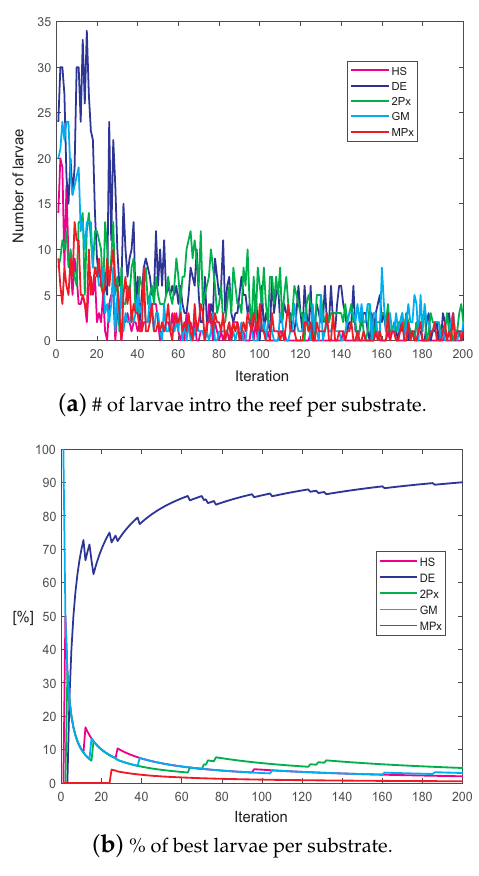
Figure 7. Number of larvae entering to the reef and percentage of best larva generated per substrate in the CRO-SL: ( a ) # of larvae into the reef and ( b ) % of best larvae per